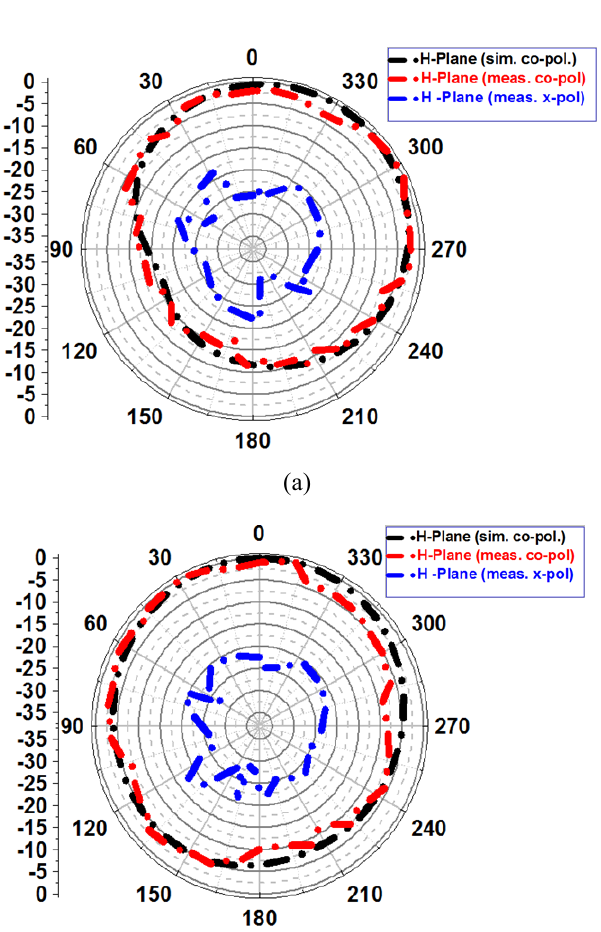
Figure 12. H- Plane normalized radiation pattern of the proposed design at (a) 5.3 and (b) 6.6 GHz